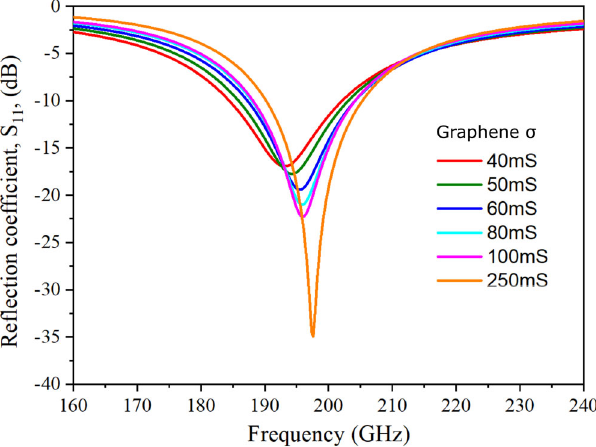
Fig. 3 Simulation results of the bilayer metasurface at 0.2 THz. Simulated S 11 parameters for the graphene/gold bilayer metasurface device for a range of graphene conductivities from 40 to 250 mS.